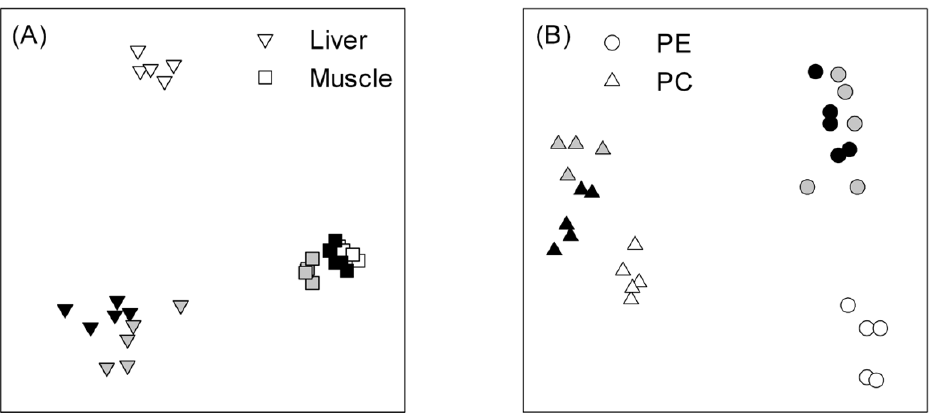
Figure 1. Multidimensional scaling plots of fatty acids (FA) in liver and white muscle tissue triacylglycerol ( A ), as well as in muscle phosphatidylethanolamine (PE) and phosphatidylcholine (PC) ( B ) of young-of-the-year striped bass sampled in November 2016 (white shapes) and March 2017 in Lower (black shapes) and Middle ponds (grey shapes).